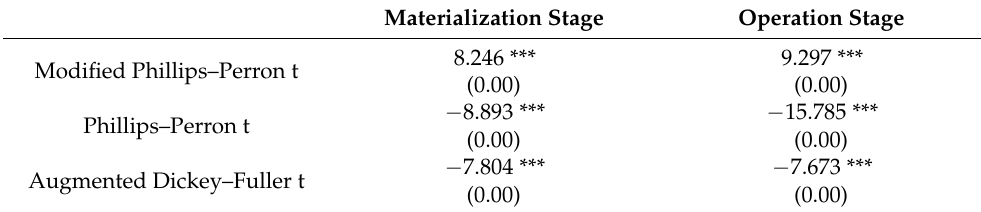
Table 5. Pedroni cointegration test